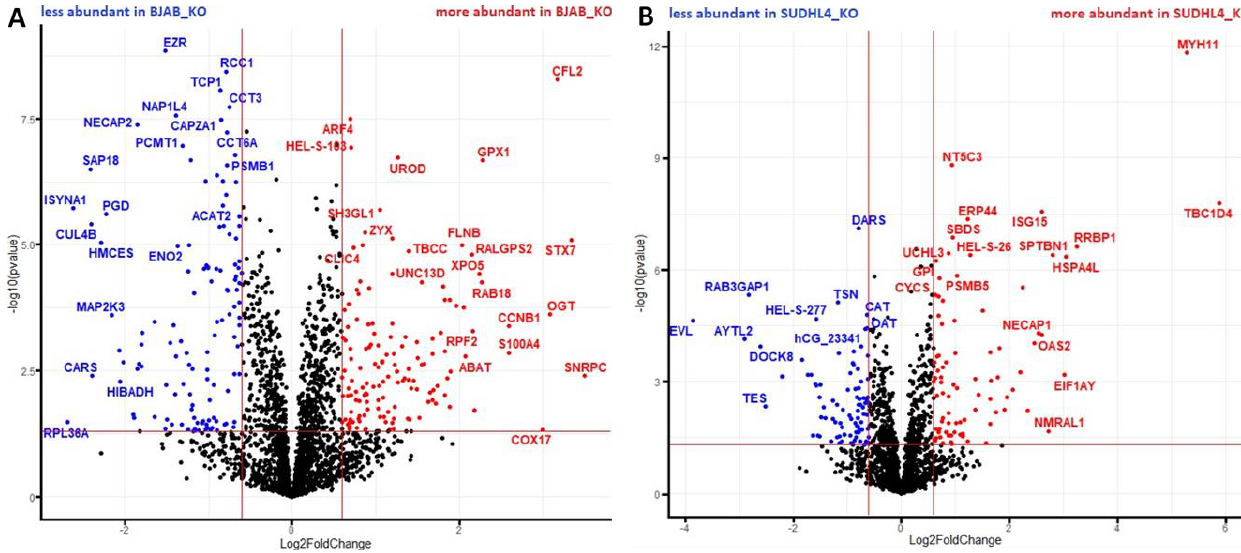
Figure 5. Volcano plot analysis of log2 protein intensity values for BJAB_KO/BJAB_WT ( A ) and SUDHL4_KO/SUDHL4_WT ( B ). Non-paired t-test with false discovery rate (FDR) correction (0.05) was implemented. Each colored dot represents a protein fulfilling the significance criteria (|log2 FC| > 0.6; p -value < 0.05). For selected significant hits gene names are